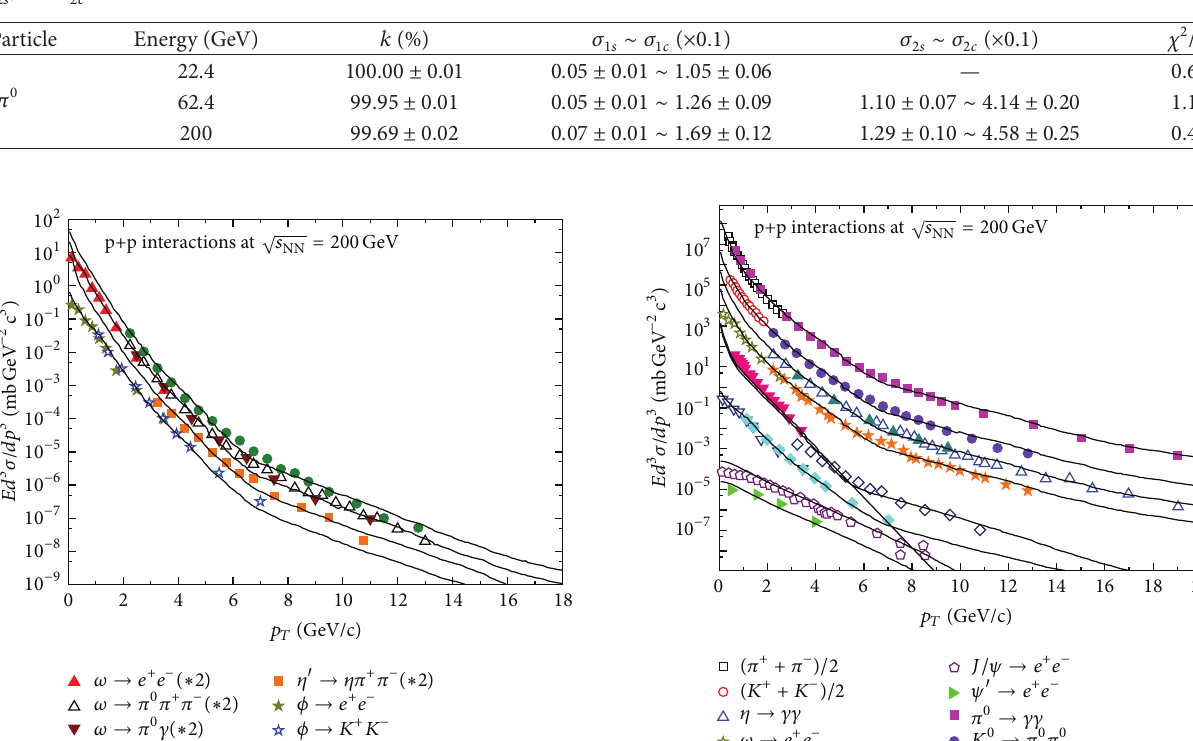
Table 2: Values of the parameters 𝑘 , 𝜎 1𝑠 ∼ 𝜎 1𝑐 , and 𝜎 2𝑠 ∼ 𝜎 2𝑐 obtained by fitting the experimental 𝑝 𝑇 spectra Figure 4. The units of 𝜎 1𝑠 , 𝜎 1𝑐 , 𝜎 𝜎 2𝑠 , and 2𝑐 are GeV/c.